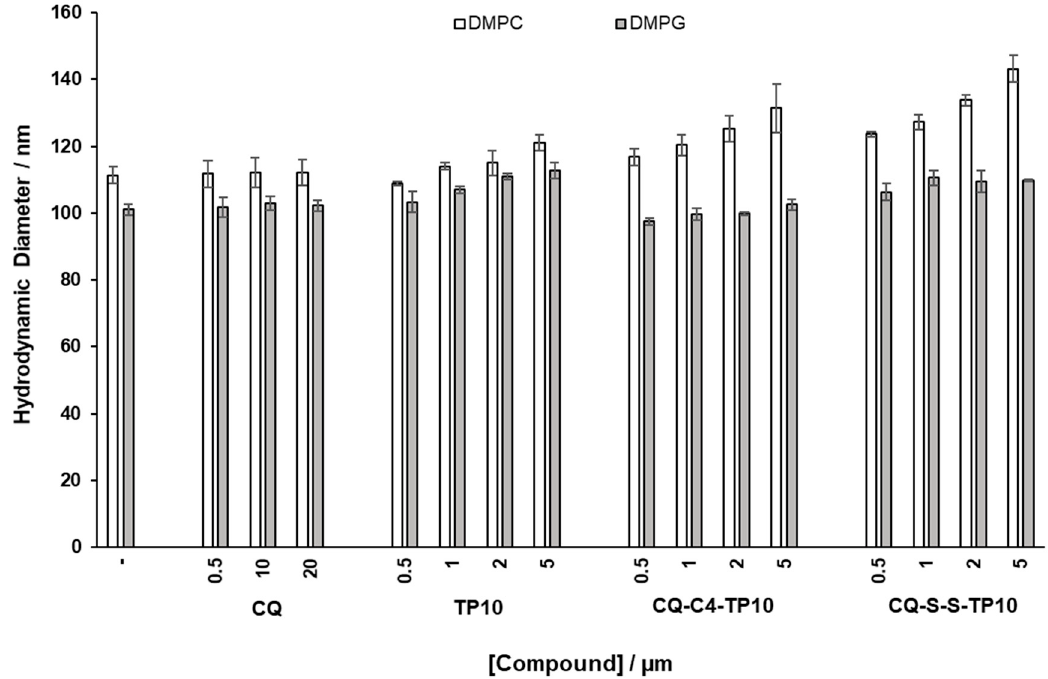
Figure 4. Effects of incubation with increasing concentrations of the test compounds on hydrodynamic diameter (HD) of zwitterionic 1,2-dimyristoyl-sn-glycero-3-phosphocholine (DMPC) and 1,2-dimyristoyl-sn-glycero-3-phosphorylglycerol (DMPG) liposomes, taken as simplistic models of niRBC and PiRBC, respectively.